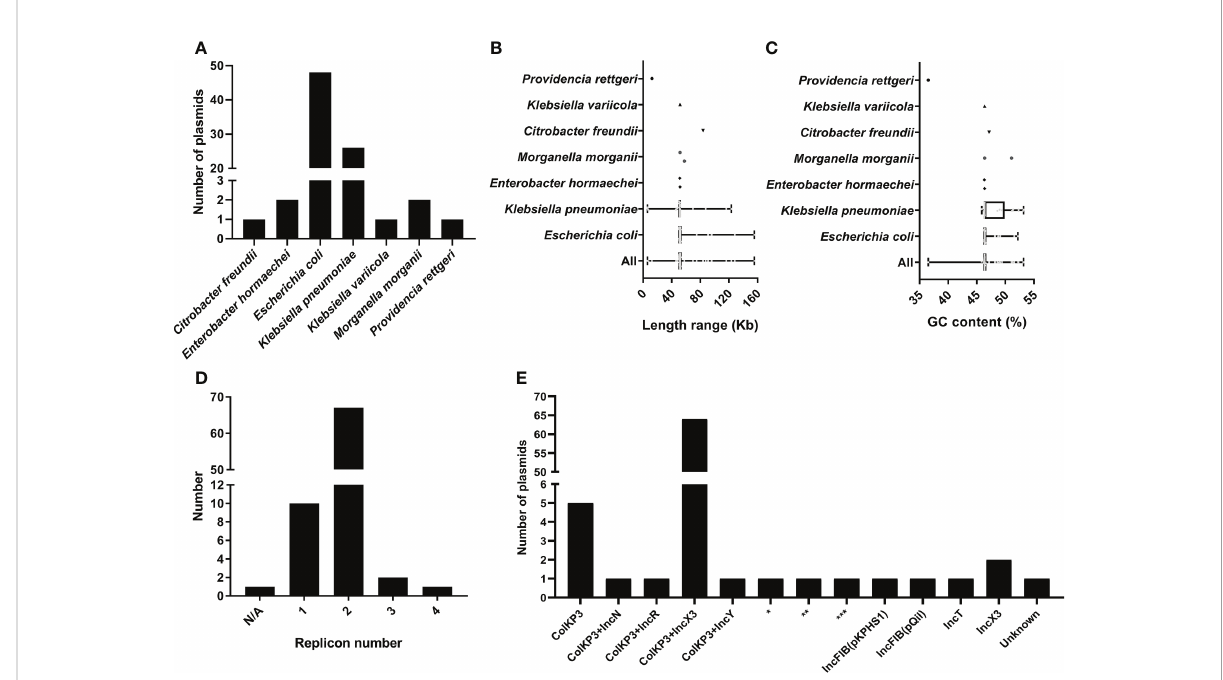
FIGURE 1 Characteristics of 81 bla OXA-181 -positive plasmids in Enterobacterales . (A) Histogram about number of plasmids distributed in different species for the 81 bla OXA-181 -positive in Enterobacterales . (B) Length distribution of the bla OXA-181 -positive plasmids in different species. (C) GC content distribution of the bla OXA-181 -positive plasmids in different species. (D) Histogram of number of replicons per plasmid for the 81 bla OXA-181 - positive plasmids. (E) Histogram of number of combination modes of different replicons among the 81 bla OXA-181 -positive plasmids. *representing ColKP3+IncFIB(pB171)+IncFII; **representing ColKP3+IncFIB(AP001918)+IncFIC(FII); ***representing ColKP3+IncFIA+IncFIB